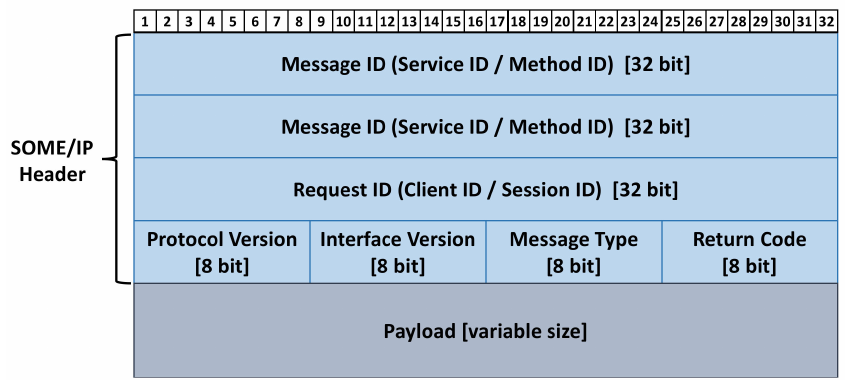
Figure 2. SOME/IP data frame structure.